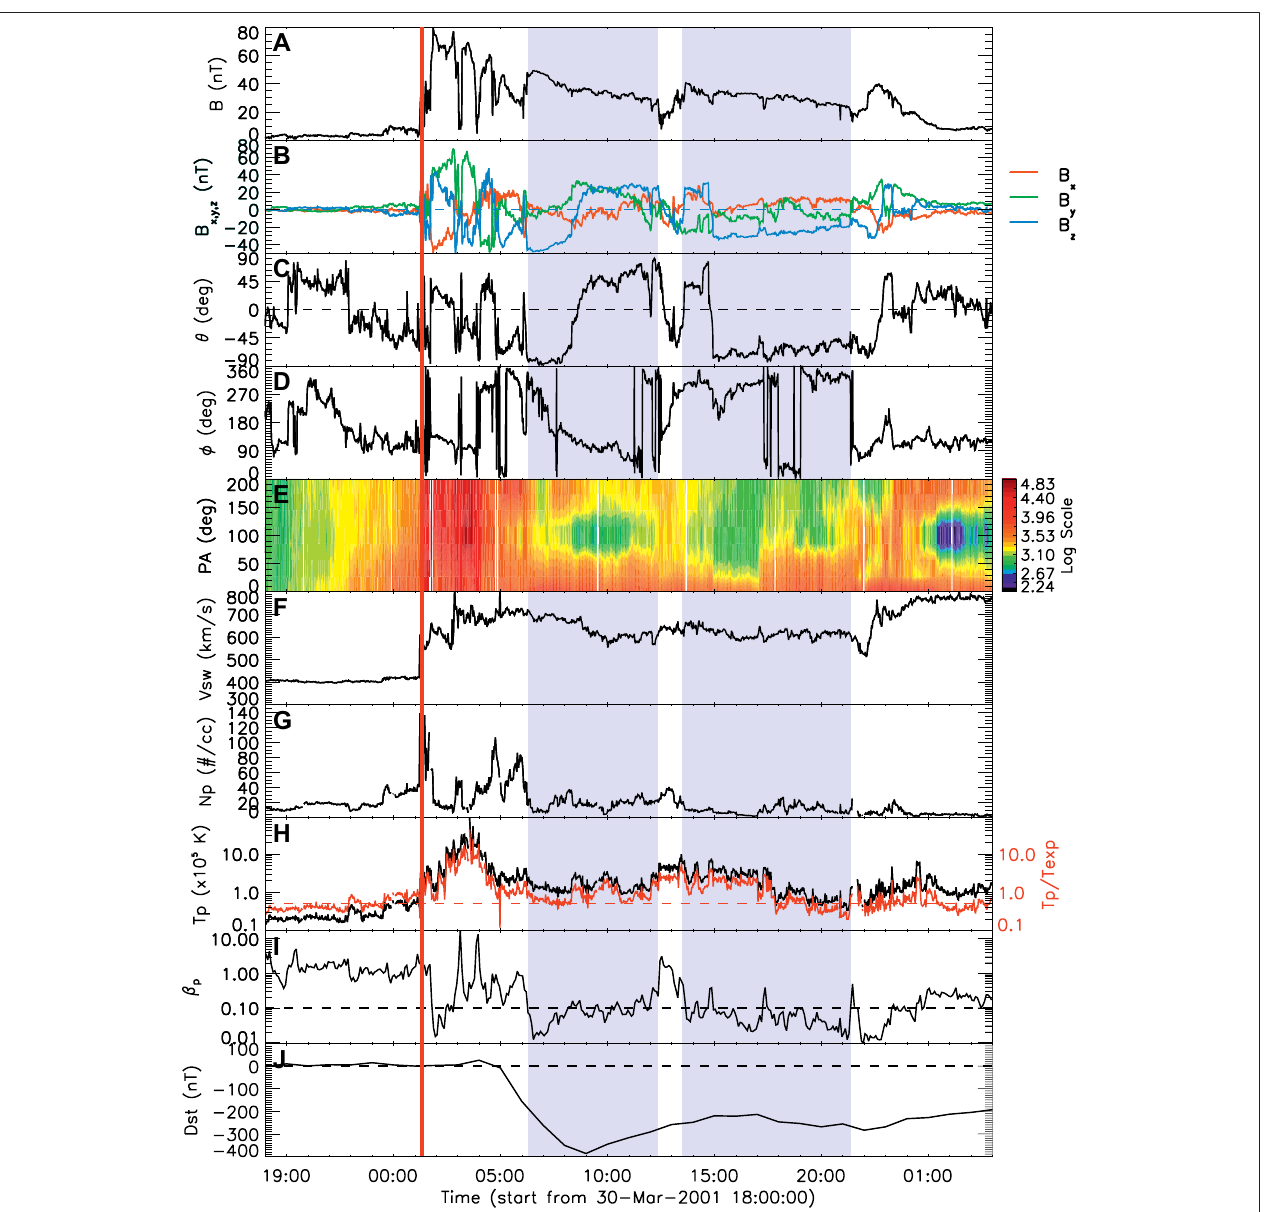
FIGURE2| Windobservationsfrom2001March 3018:00to2001April104:00withtheassociatedgeomagneticstormindex(Dst).Thepanelsarethesameasin Figure 1 .